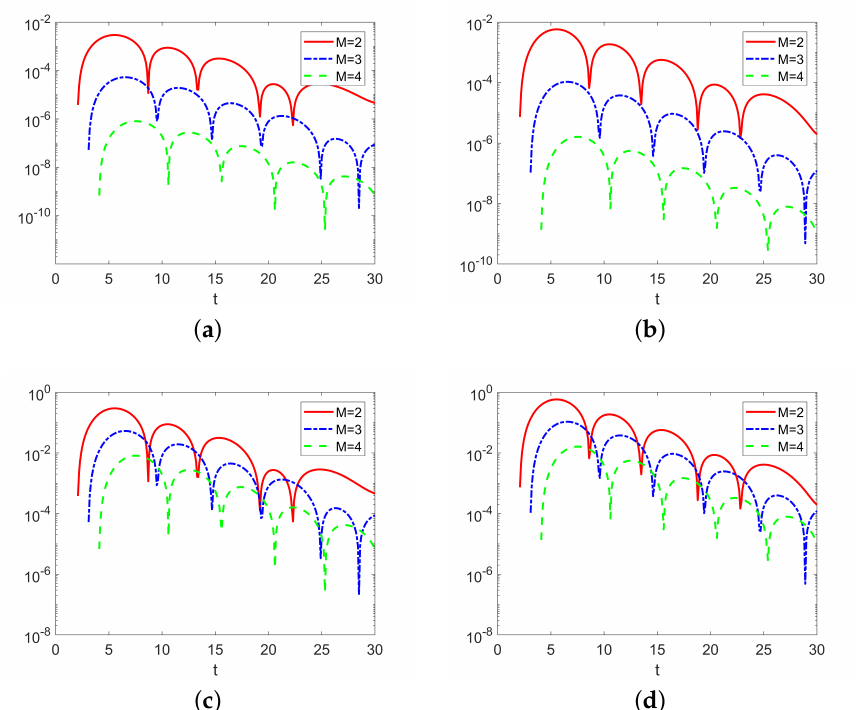
Figure 2. Absolute errors (log-scale) of numerical solutions for Example 1, computed using three different T M schemes of increasing orders, with h = 0.1. ( a , b ) Absolute errors for the first and second component, respectively. ( c , d ) Errors divided by h M .